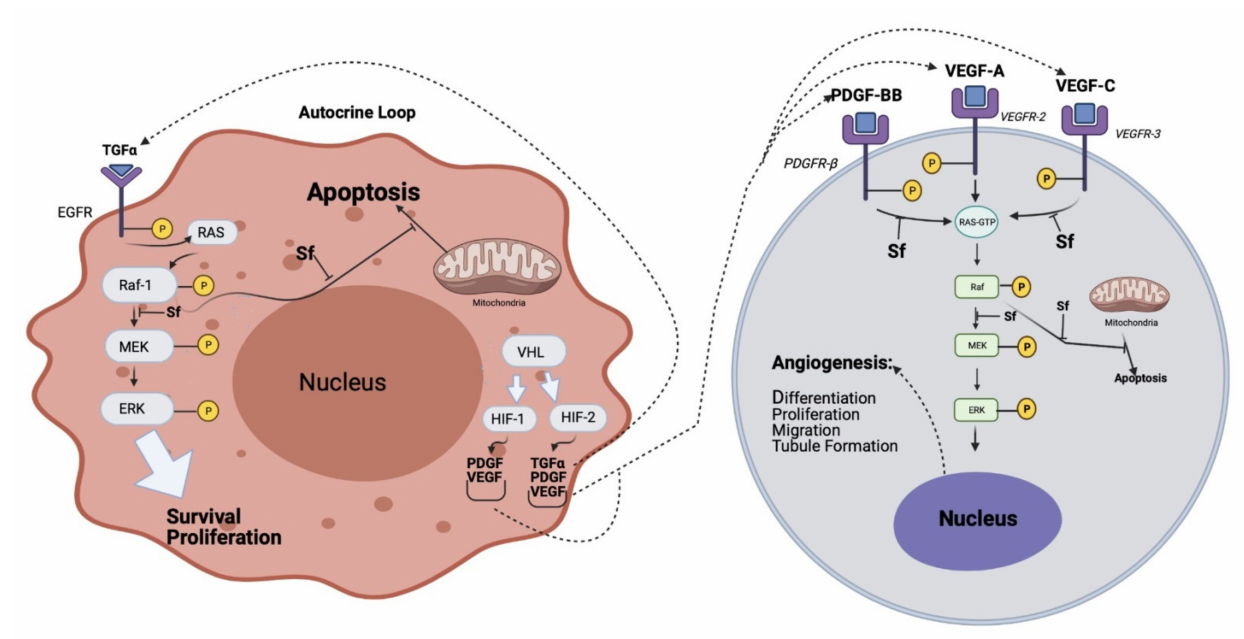
Figure 2. Dysregulation of Signaling through Raf-1 in tumor cells (left panel), endothelial cells, and/or pericytes (right panel) that could result in tumor growth and/or angiogenesis by an autocrine mechanism in HCC, and the effect of sorafenib (Sf), The white arrows indicate the effect on intra-cellular signal molecules or pathways. The dotted arrows indicate the effect on cell membrane receptors (Modified from